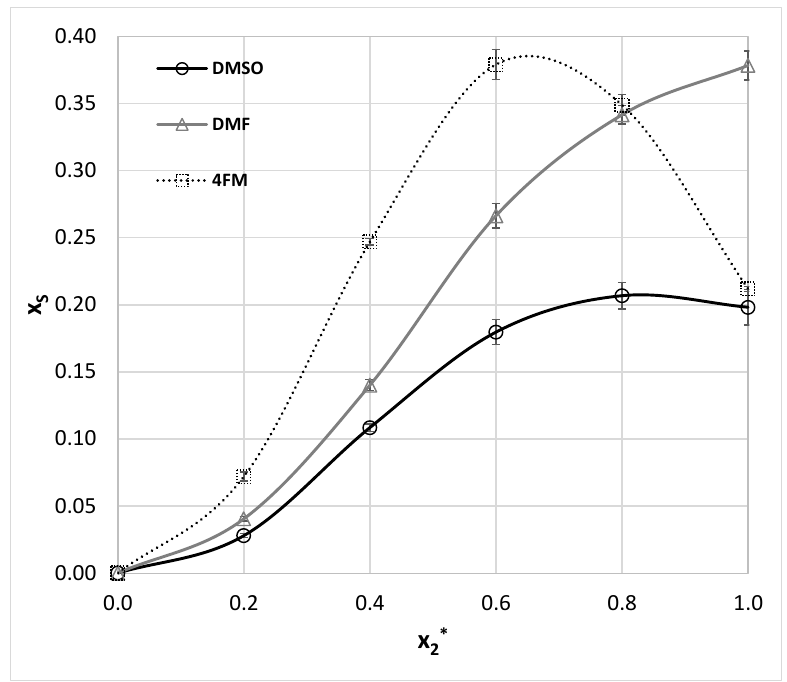
Figure 4. The results of salicylamide solubility measurements (molar fraction, x S ) at room temperature in aqueous DMSO, DMF, and 4FM mixtures (x 2 * stands for the organic component mole fraction in the binary solvent). The error bars denote standard deviation values ( n = 3).